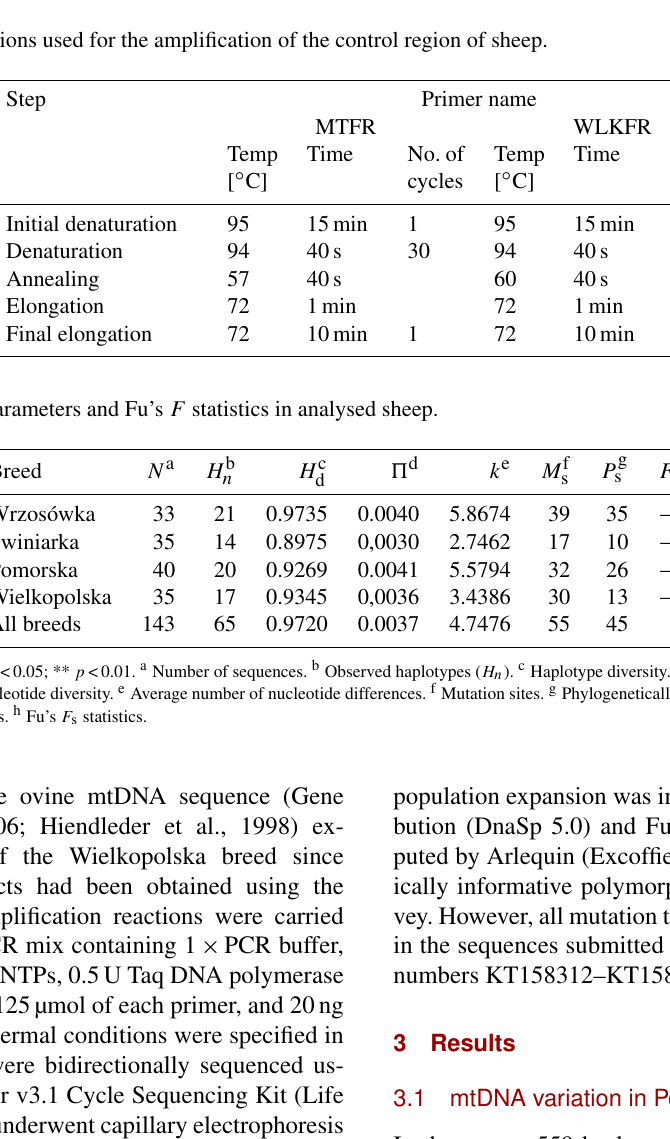
Table 2. PCR cycling conditions used for the amplification of the control region of sheep.